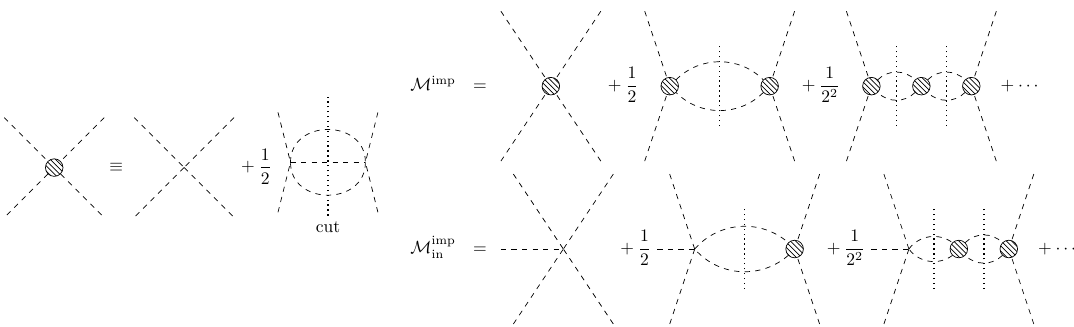
Figure 2 . Diagrammatic interpretation of our improvement in 2 → 2 and 2 → 3 amplitudes. ( Left ): an effective vertex (denoted by a meshed blob) includes the tree-level four-point vertex and the one-loop vertex induced by the tree-level five-point vertex. ( Right ): the improved amplitude for 2 → 2 and 2 → 3